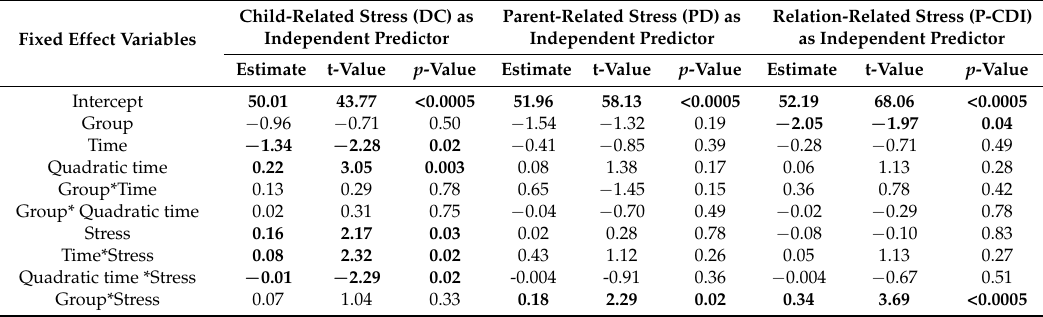
Table 3. Children’s attentional problems and associations with maternal parenting stress. Fixed Effect